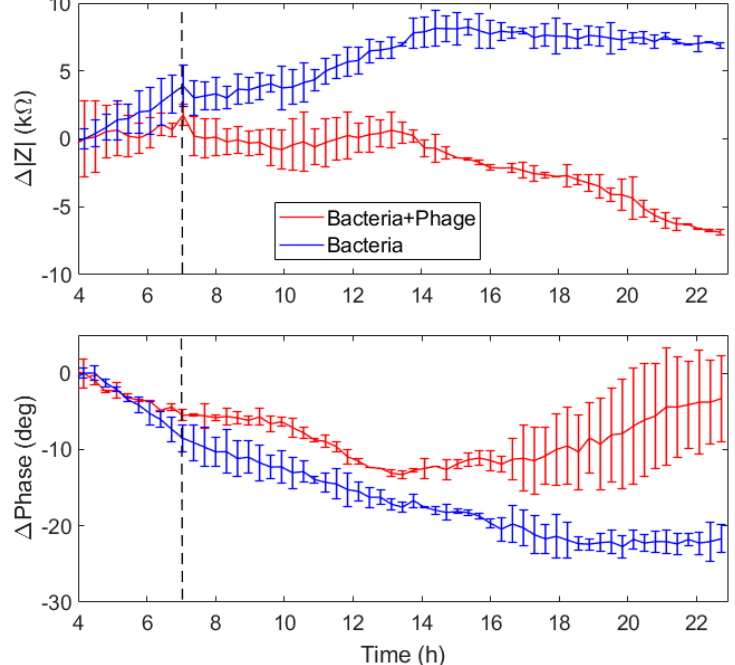
Figure 11. Variations of the module and phase impedance values at 100 mHz of the wells containing the bacterium Lactococcus lactis (in blue color), and the bacterium exposed to the phage (in red color) (7 h), with respect to the moment of bacterial inoculation (4 h).